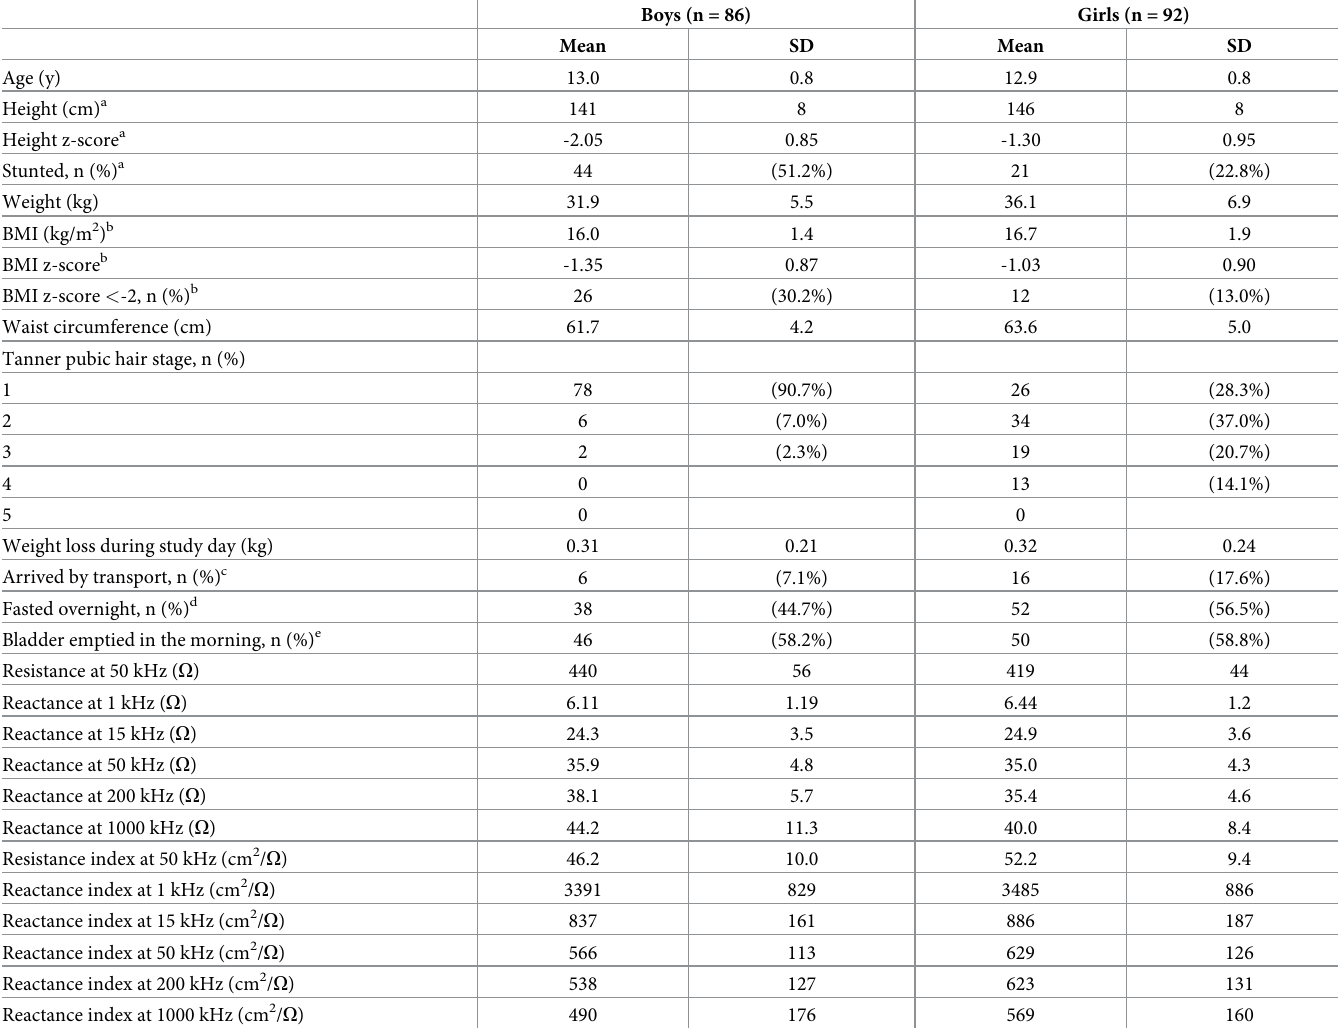
Table 1. Anthropometric and other characteristics applied in the modelling